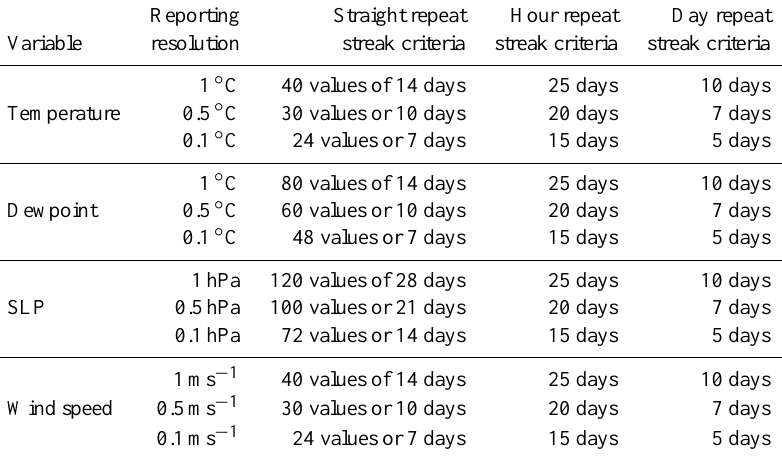
Table 4. Streak check criteria and their assigned sensitivity to typical within-station reporting resolution for each variable. Reporting Straight repeat Hour repeat Day repeat Variable resolution streak criteria streak criteria streak